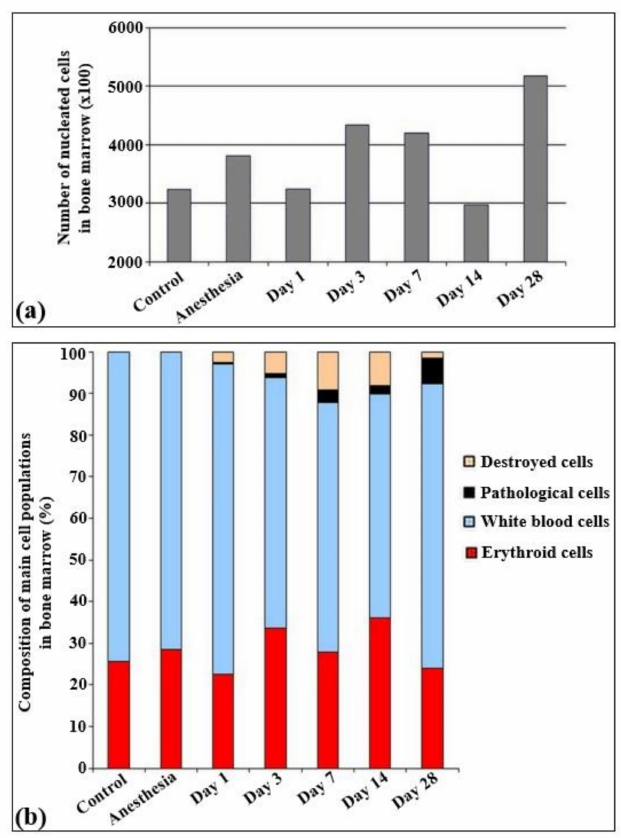
Figure 3. Cellularity and relative changes in the cell population of bone marrow in control rats and after the irradiation with the laser-driven UPEB. ( a ) Total amount of nucleated cells in bone marrow smears ( × 100). ( b ) Composition of main cell populations of bone marrow in control rats and after the influence of electron beam